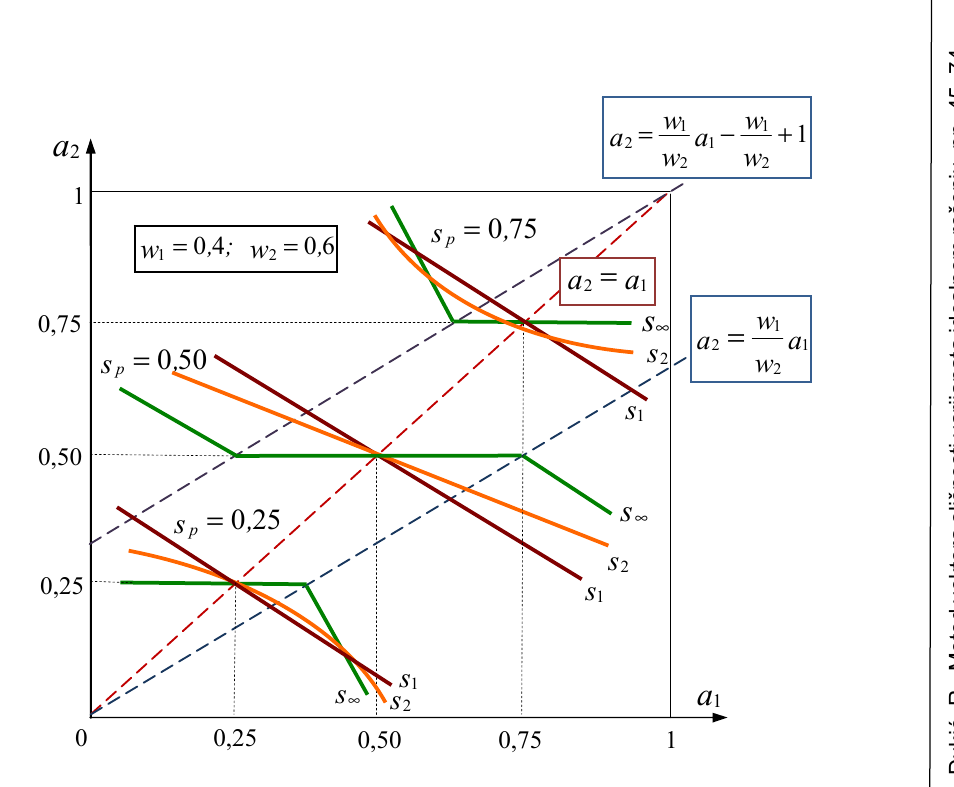
= с двумя критериями p = for two = for C)i( s p 12